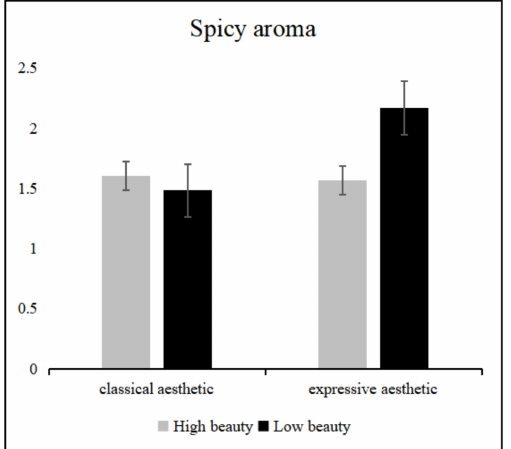
Figure 6. Spicy aroma scores for different pattern types with different beauty levels of plates. Error lines represent 95% confidence